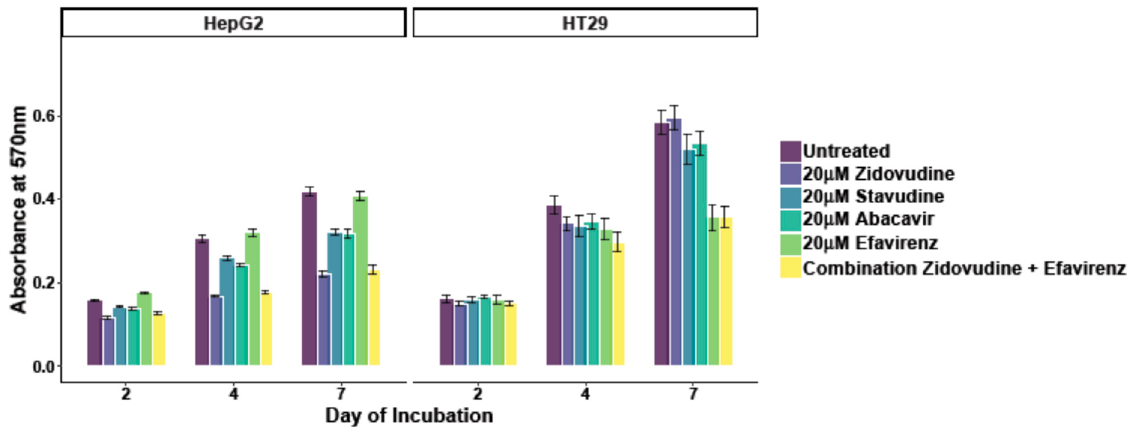
Figure 3. Decreased metabolic activity after treatment with Zidovudine in HepG2 cells and Efavirenz in HT29 cells after 2, 4 and 7 days of incubation.